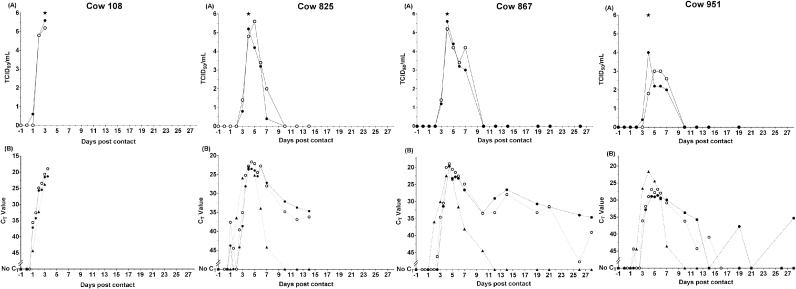
FMDV detection in samples collected at regular intervals from all cows. Virus titrations in BTY cells (A) and rRT-PCR using Method B (B) for skimmed and whole milk fractions and serum (B only). Average CT is derived from the mean of 2 replicates. The development of lesions in at least one foot indicates the onset of clinical signs. : Onset of clinical signs, : whole milk, : skimmed milk, : serum.